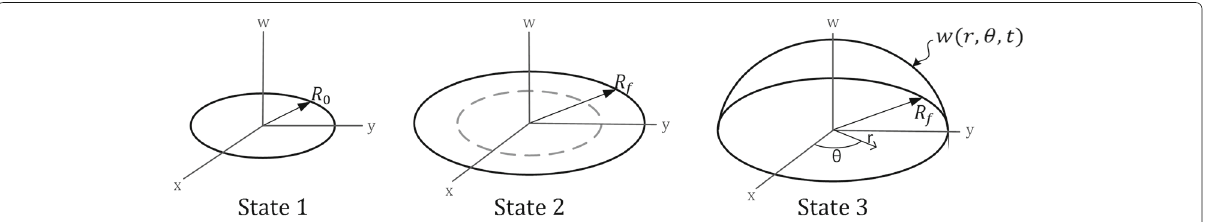
Fig. 7 Different states of deformation of a membrane